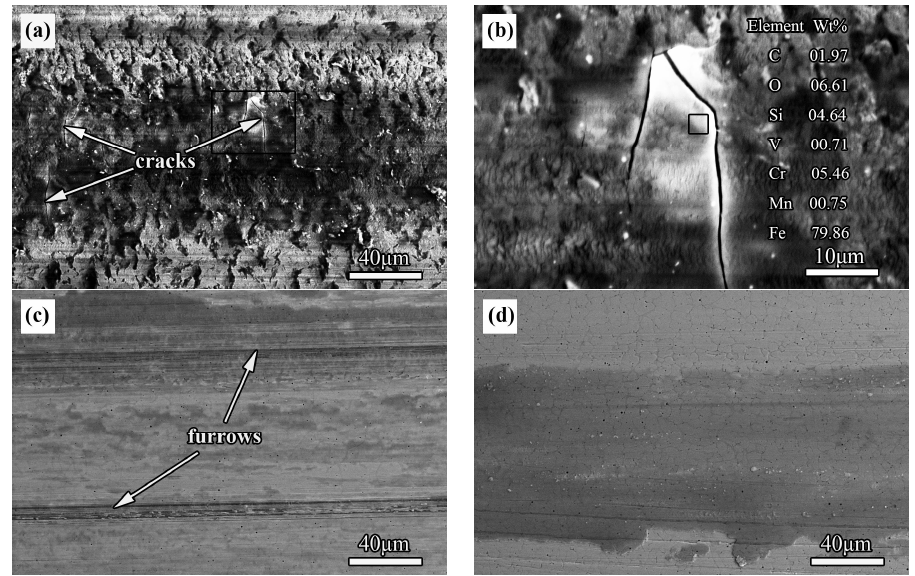
Figure 5. SEM morphologies of worn scar on laser cladded Fe-based coatings: ( a ) worn scar on S1; ( b ) crack and EDS analysis on S1; ( c ) worn scar on S2; ( d ) worn scar on S3.